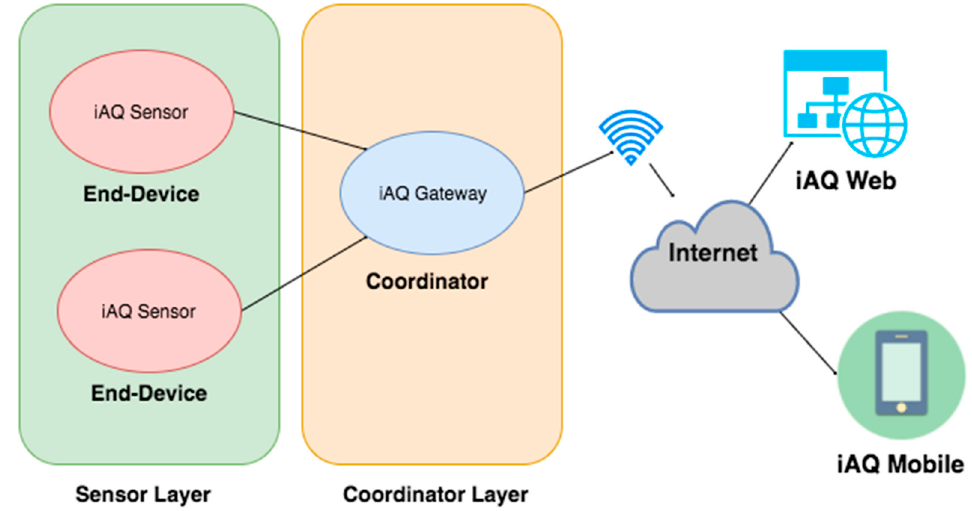
Figure 1. Wireless sensor networks (WSN) architecture.